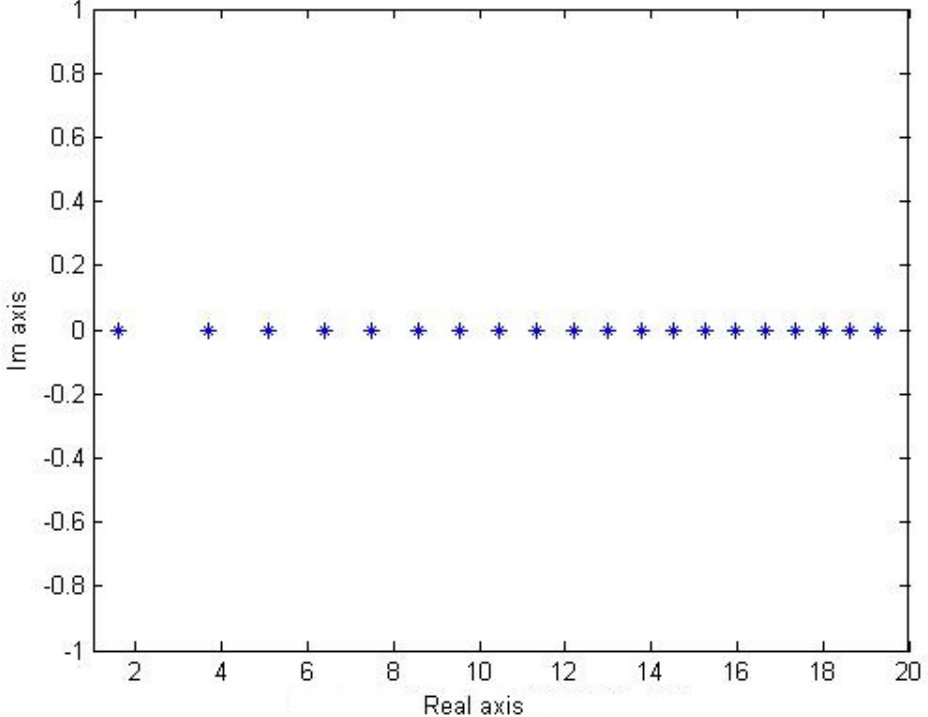
Figure 16. Energy eigenvalues of the PDM Hamiltonian associated with Rath potential for 01.0 =λ .